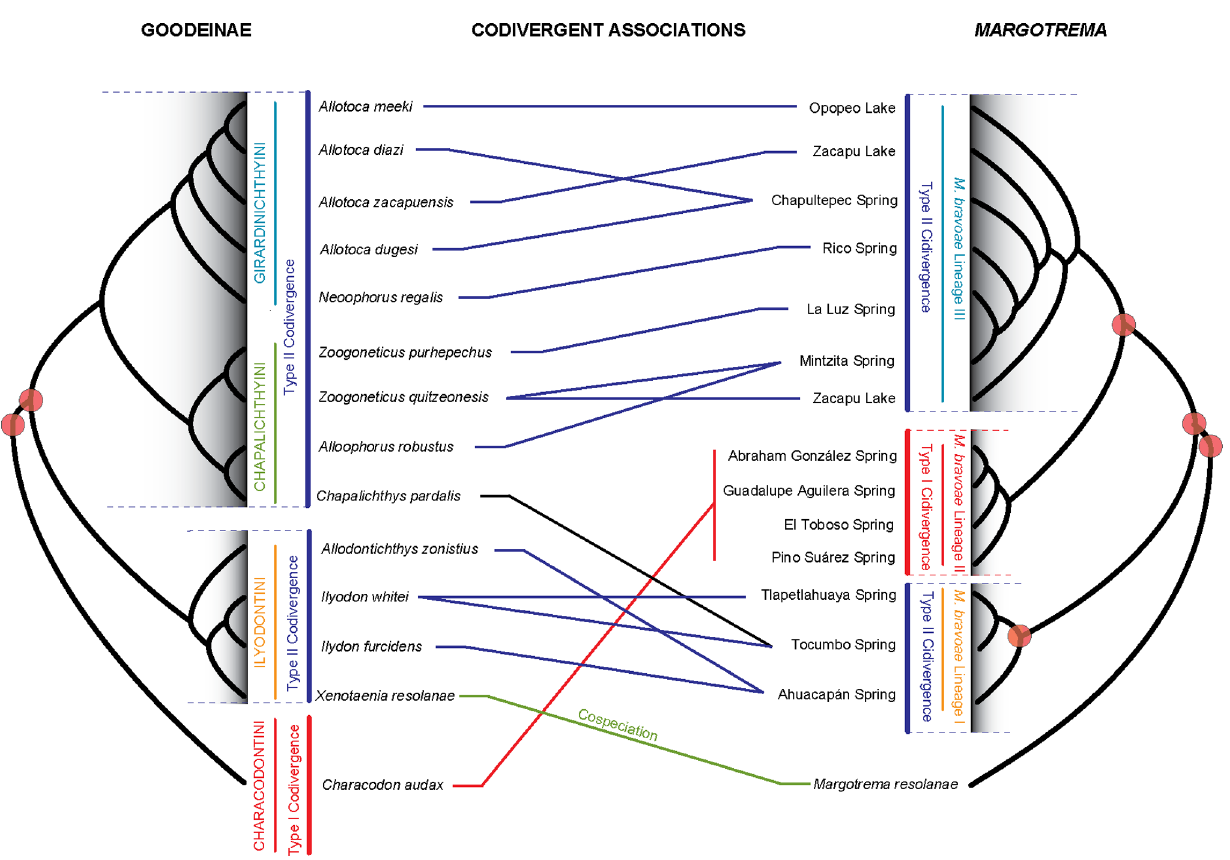
Figure 4. Tanglegram depicting the three levels of codivergent associations between Goodeinae and Margotrema . Level 1: Species- Species , representing the association Xenotaenia resolanae - Margotrema resolanae (green line). Level 2: Species-Lineage , representing the association Characodon audax - Margotrema bravoae Lineage II (red line). Level 3: Tribe-Lineage , representing the associations between Ilyodontini- M. bravoae Lineage I (blue lines) and Girardinichthyini/Chapalichthyini- M. bravoae Lineage III (blue lines). Red circles at nodes represent statistically supported codivergence events established by cophylogenetic analysis in TreeMap.